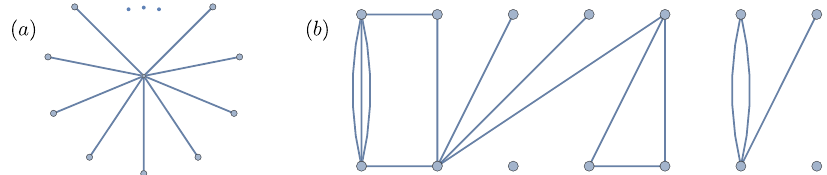
Fig. 3 Graph models of perfect tensor and bipartite entanglement. Minimal cuts through these graphs are identi fi ed with entropies of subregions. a Perfect tensor `PT', equation (18). b Bipartite entanglement `EPR', equation